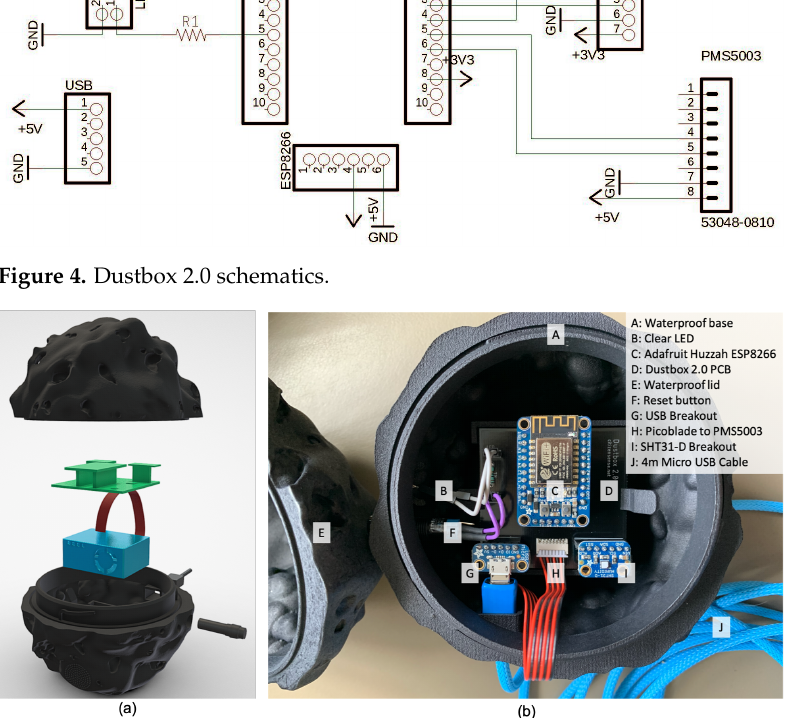
Figure 5. Dustbox 2.0: ( a ) 3D exploded view; and ( b ) exploded view with